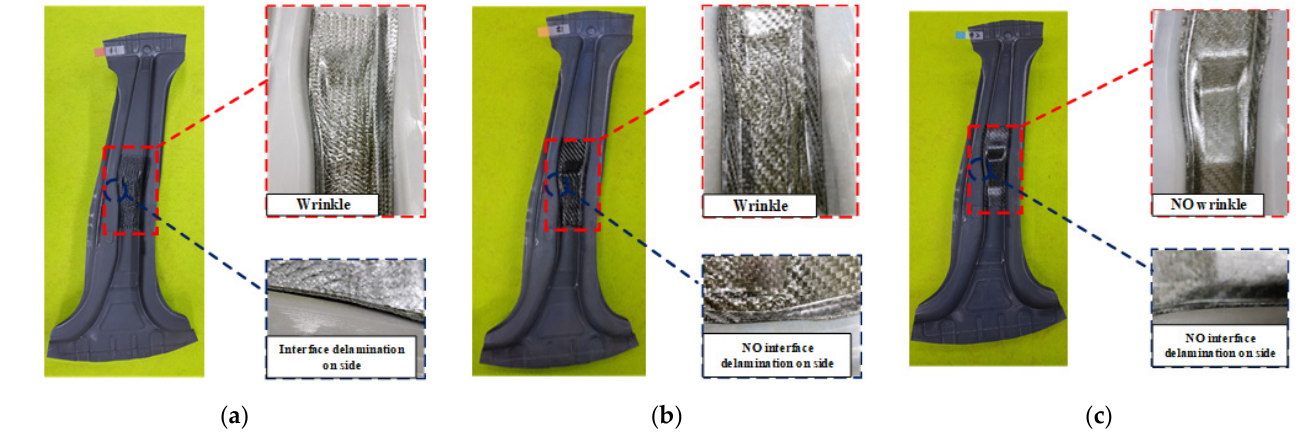
Figure 14. Observation of defects at different tool temperatures. ( a ) 90 °C. ( b ) 110 °C. ( c ) 130